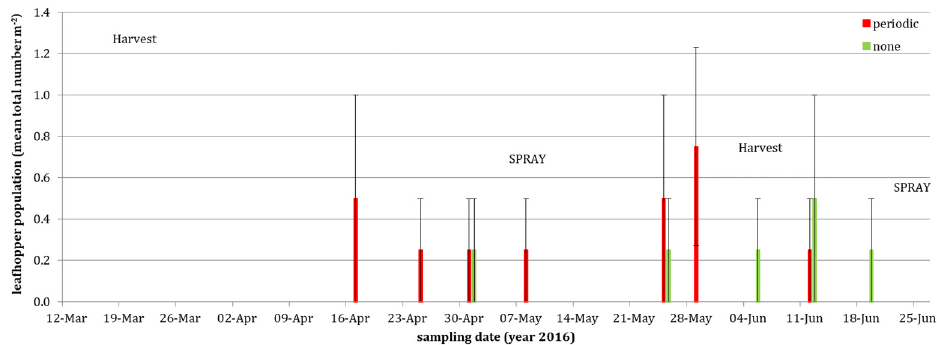
Figure 8. Population (expressed as mean total number per m 2 ) of leafhoppers found in the plots of the meadow within the vineyard, under the no- and periodic-harvest treatments from 12 March to 26 June in 2016.